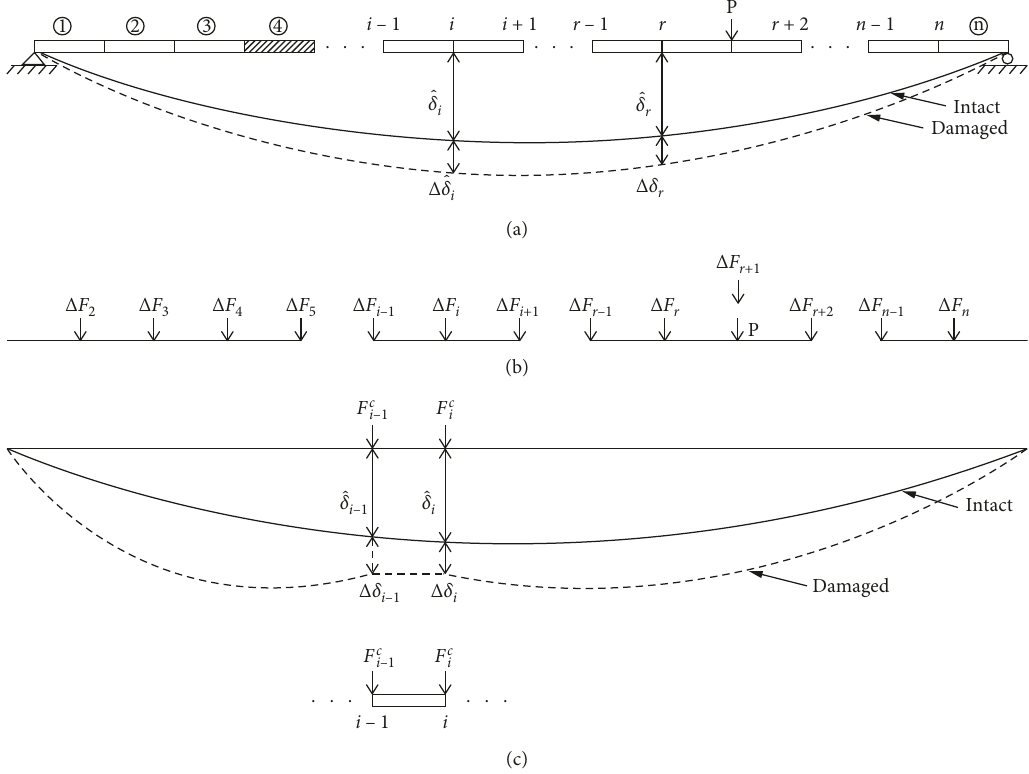
Figure 1: Deflection of a simply supported beam of (a) deflected curves, (b) a force set required for describing the displacement variations, and (c) constraint forces at nodes of a local element i